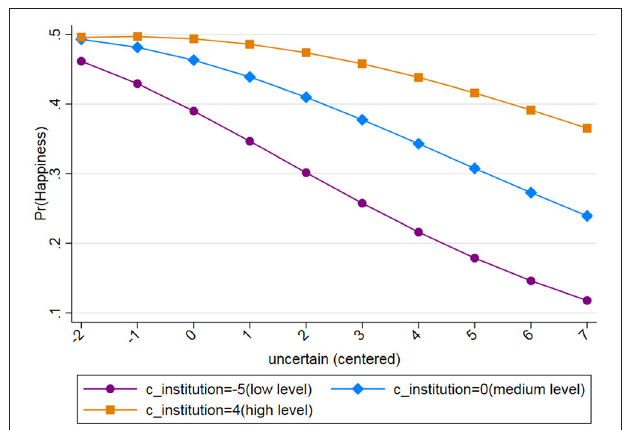
FIGURE 1 | The relationship between uncertainty and happiness under different levels of institutional evaluation.